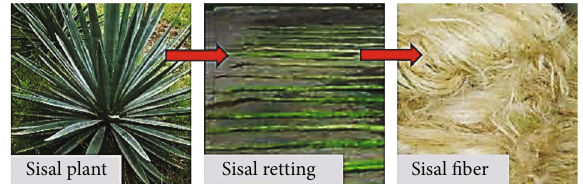
Figure 2: Sisal fi bre abstraction from Agave sisalana shrub.